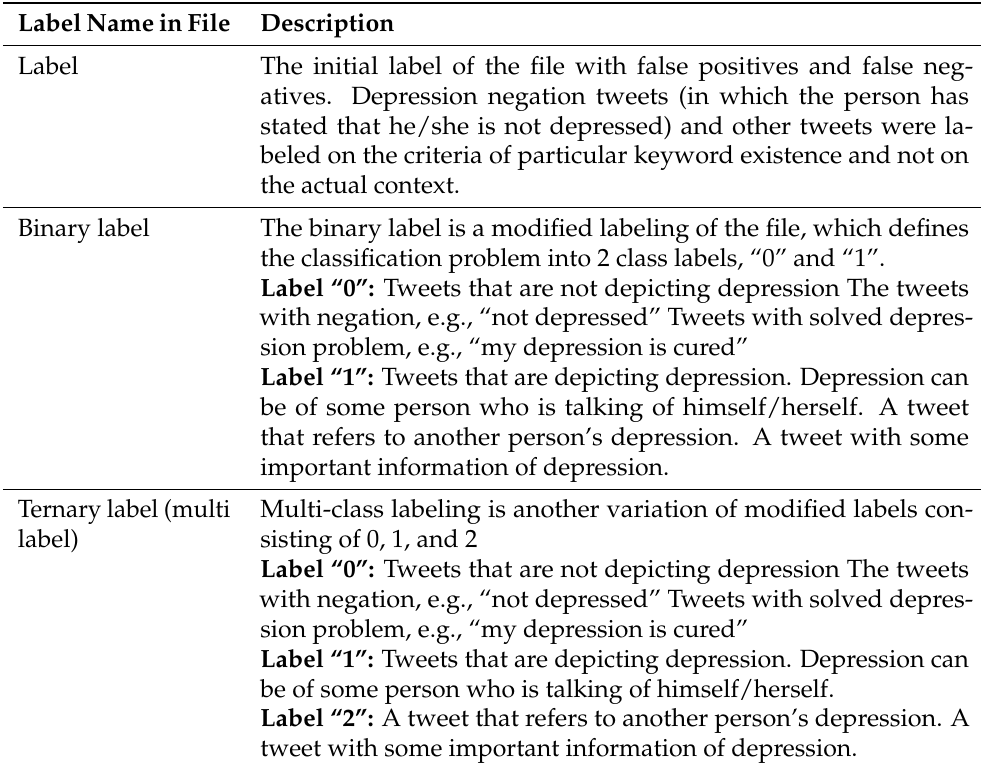
Table 3. Annotation